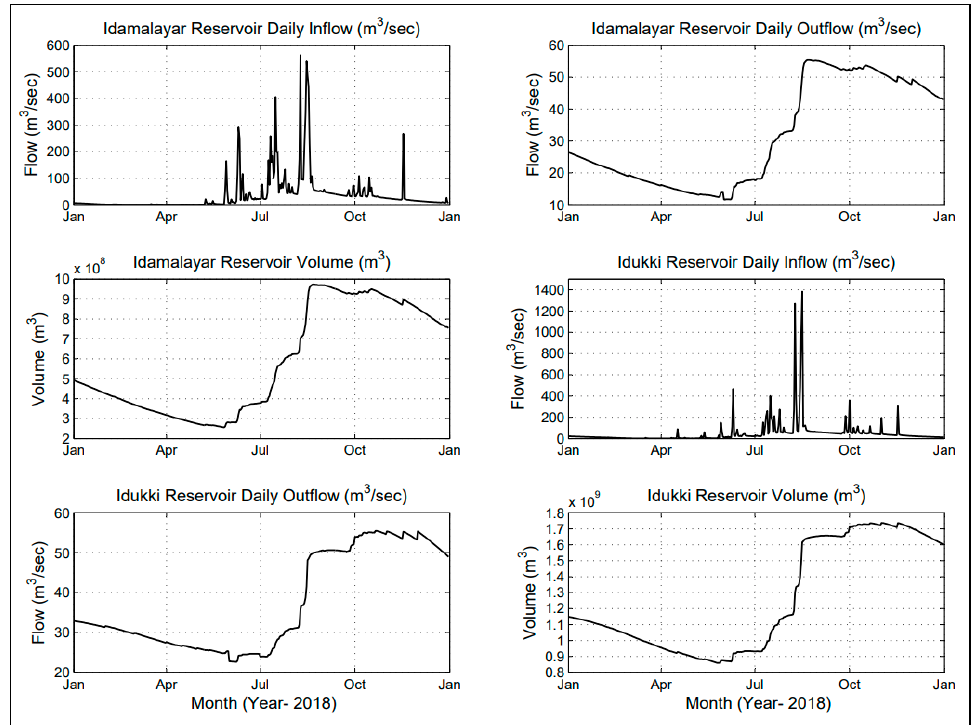
Figure 7. Reservoir Inflow, Outflow and storage plot considering reservoir operation.